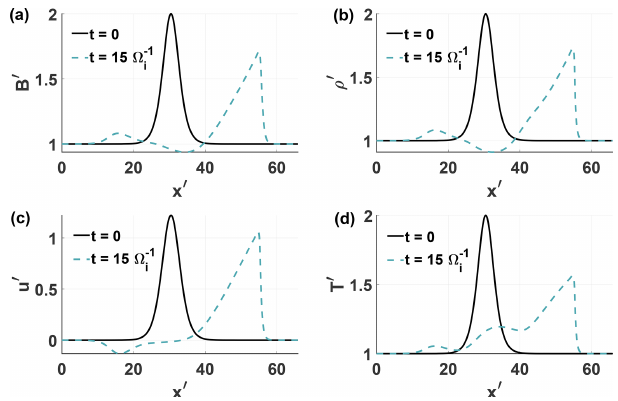
Figure 12. Solution of the modified 1D MHD equation for the ini- tial conditions given by Eqs. (15) to (18). The solid black line shows the initial conditions. The dashed line illustrates the solution com- puted with Clawpack after a time t = 15 (cid:127) − 1